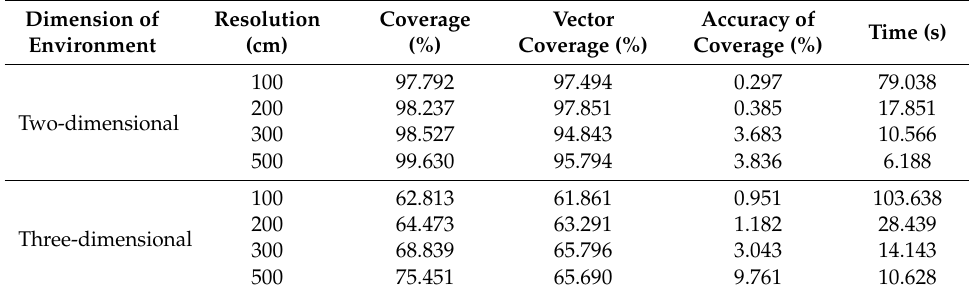
Figure11. Convergence diagram based on CMA-ES algorithm for raster models: ( A ) two dimensions; and ( B ) three dimensions. Table 2. Values obtained based on CMA-ES algorithm for two- and three-dimensional models. Dimension of